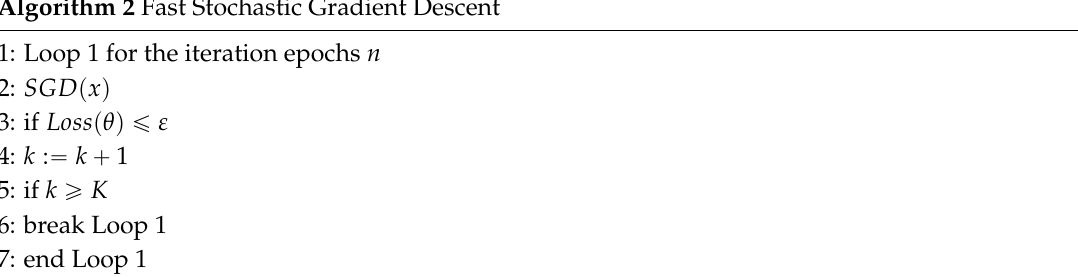
Algorithm 2 Fast Stochastic Gradient Descent